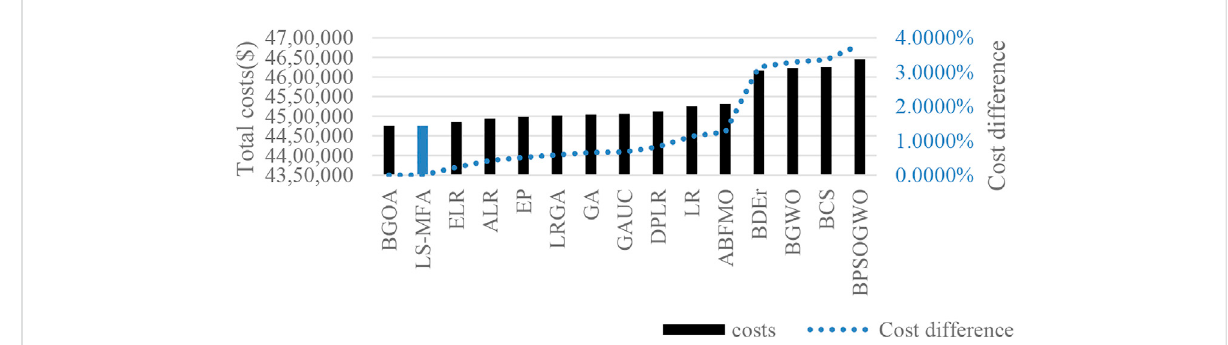
FIGURE 12 Comparison of total cost with reported optimization techniques for 80-unit system.